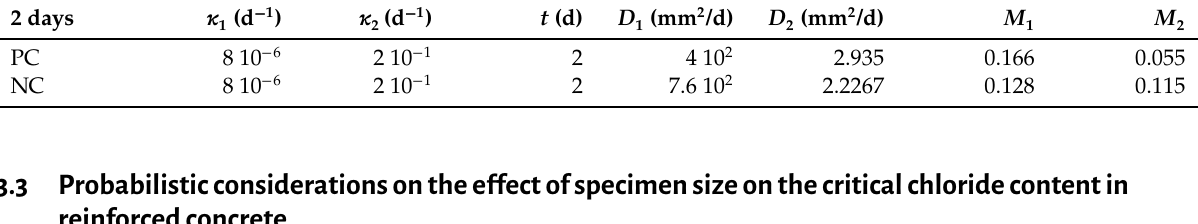
Table 7: Parameter values for C